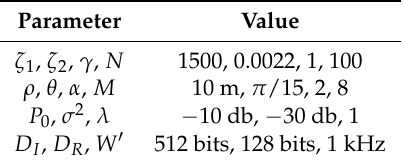
Table 1. Parameters used in